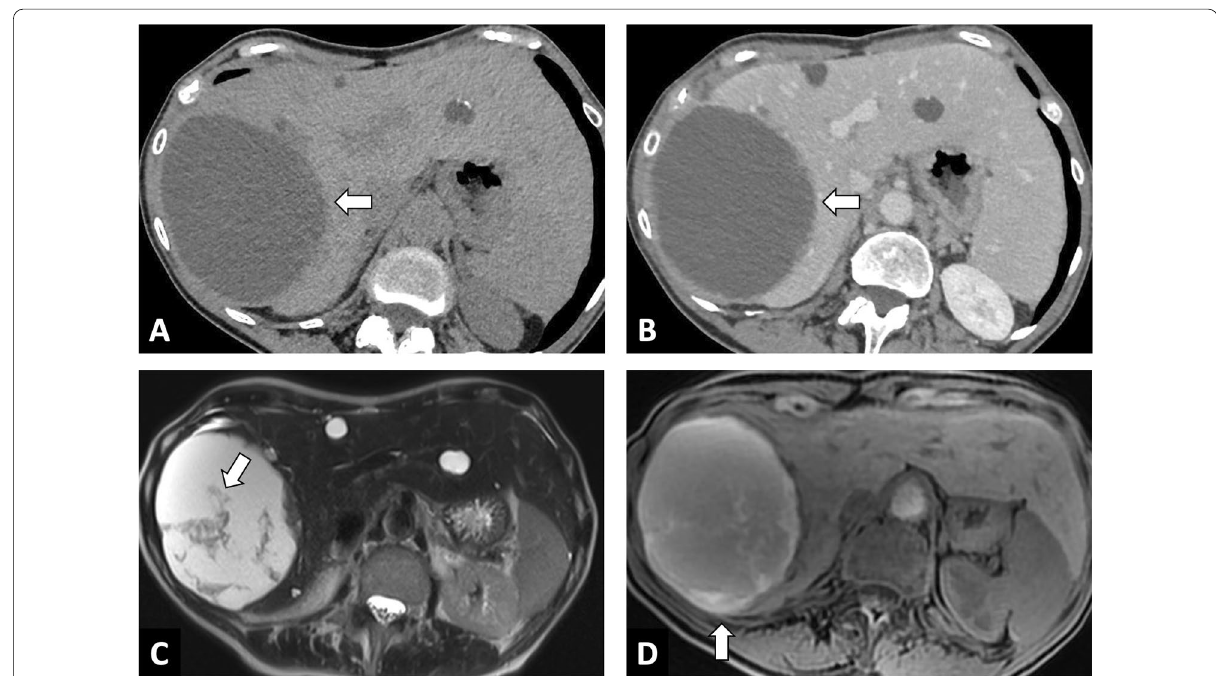
Fig. 14 Differential diagnosis of a cystic echinococcosis lesion in a 78‑year‑old woman. A Unenhanced CT image in the axial plane showing a right liver cyst. B CT image in the axial plane at the portal phase showing a cystic lesion of the right liver with thickening wall. C T2‑weighted MR image in the axial plane showing heterogeneous content without daughter cysts. D T1‑weighted MR image in the axial plane showing hyperintense signal of the liver cyst confirming the diagnosis of hemorrhagic liver cyst